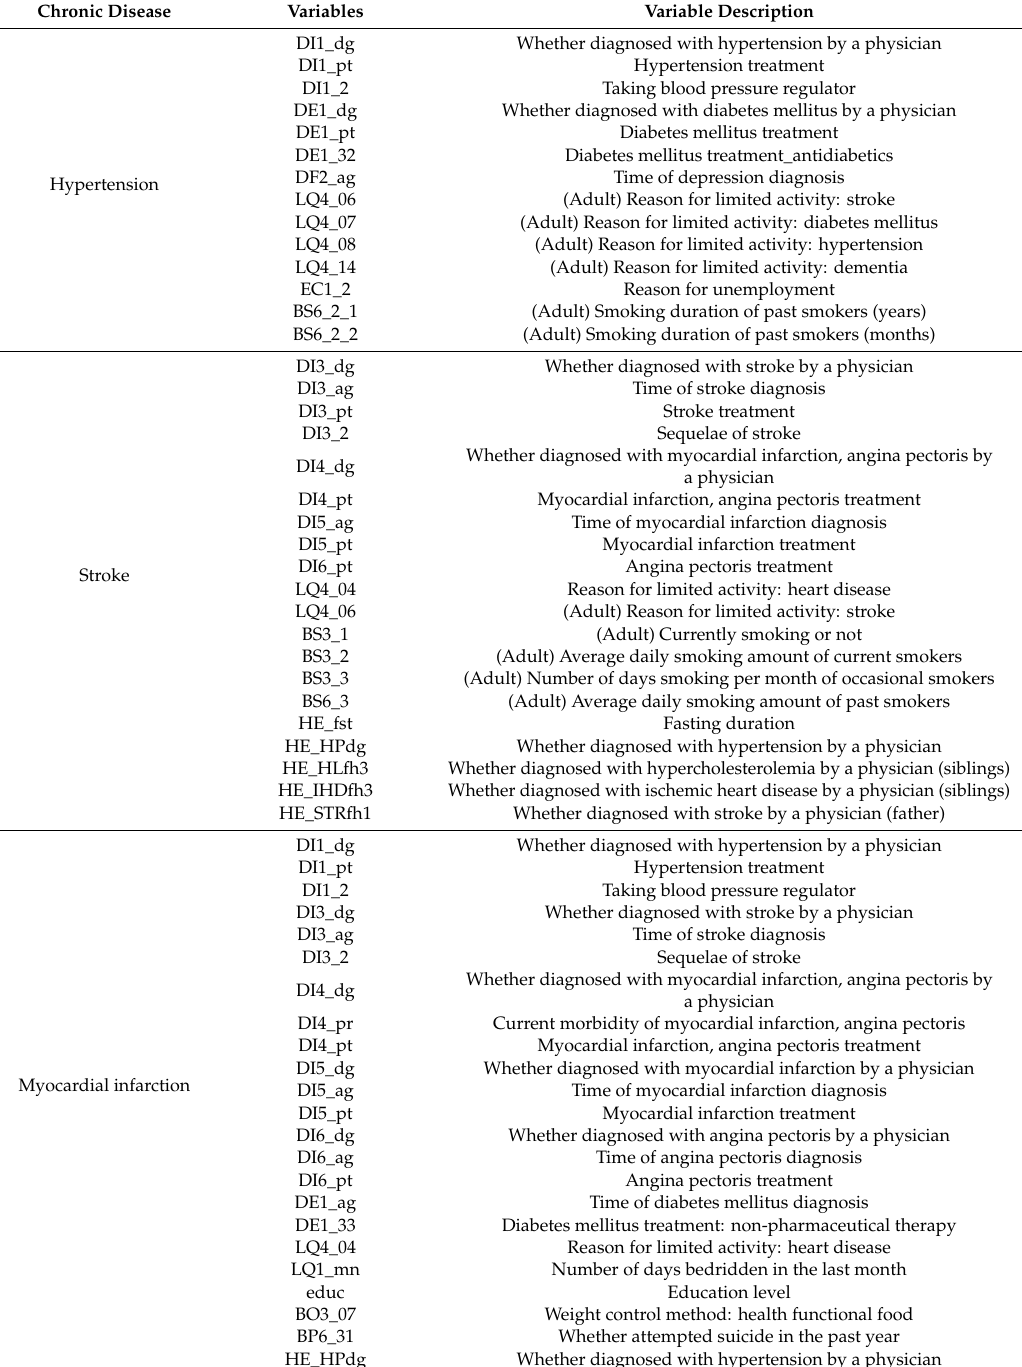
Table A2. Chronic disease variables,